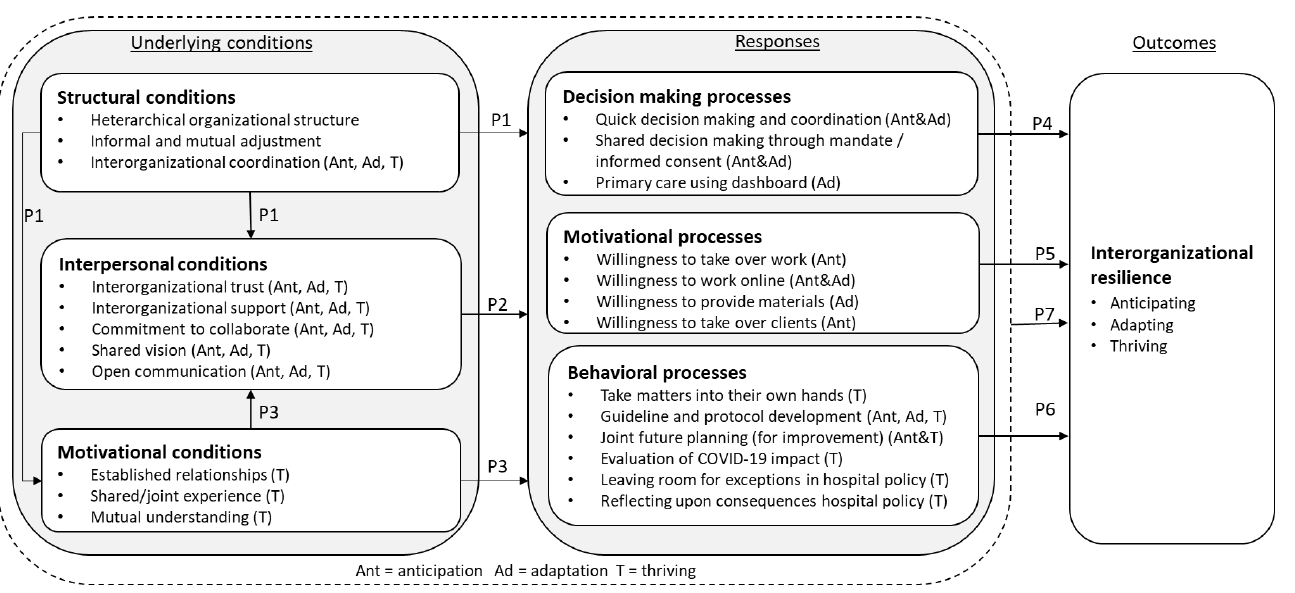
Figure 2. Conceptual